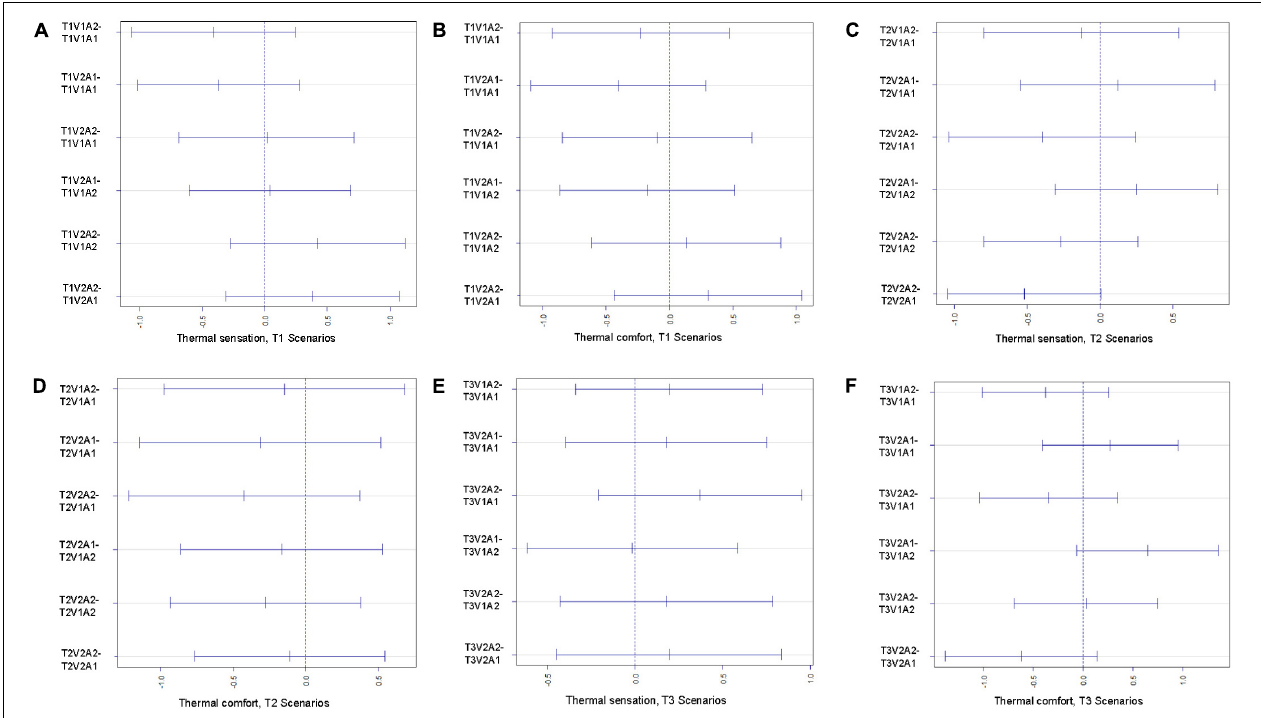
FIGURE 6 | Differences in mean levels of thermal sensation (A) and comfort (B) votes in T1 Scenarios, thermal sensation (C) and comfort (D) votes in T2 Scenarios, and thermal sensation (E) and comfort (F) votes in T3 Scenarios.